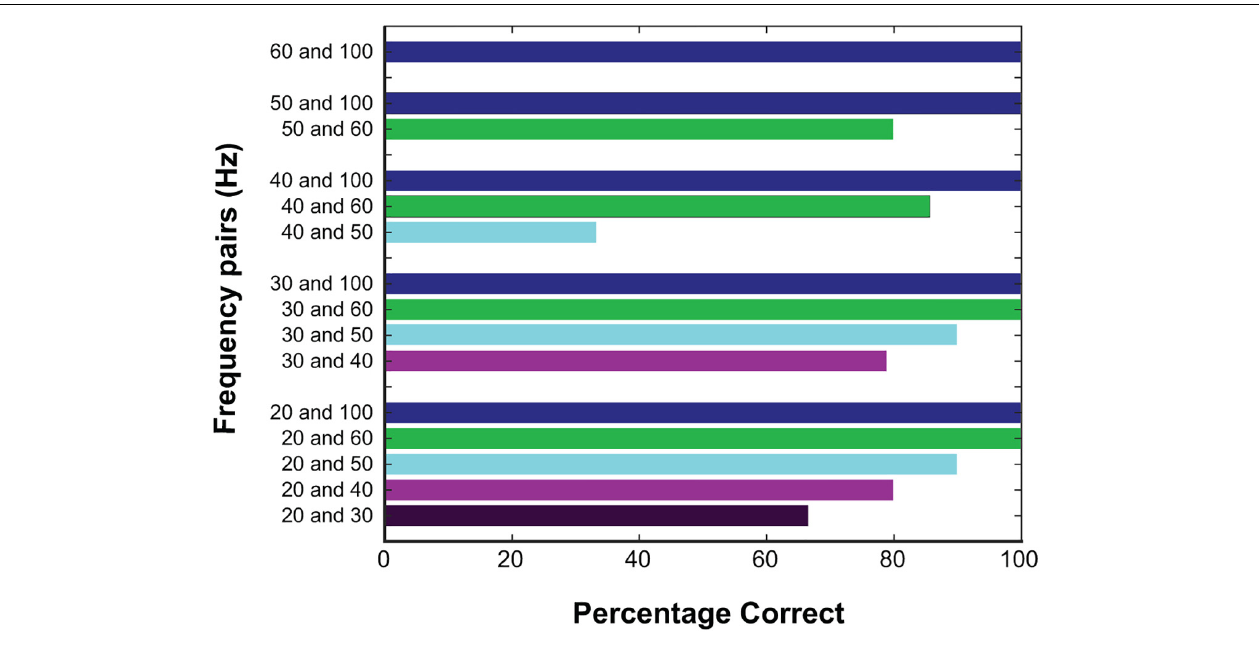
FIGURE 3 | Responses at different frequencies tested. Percentage correct for all trials based on the frequencies being compared, color coded based on the higher frequency. Correct responses were high with larger frequency differences.